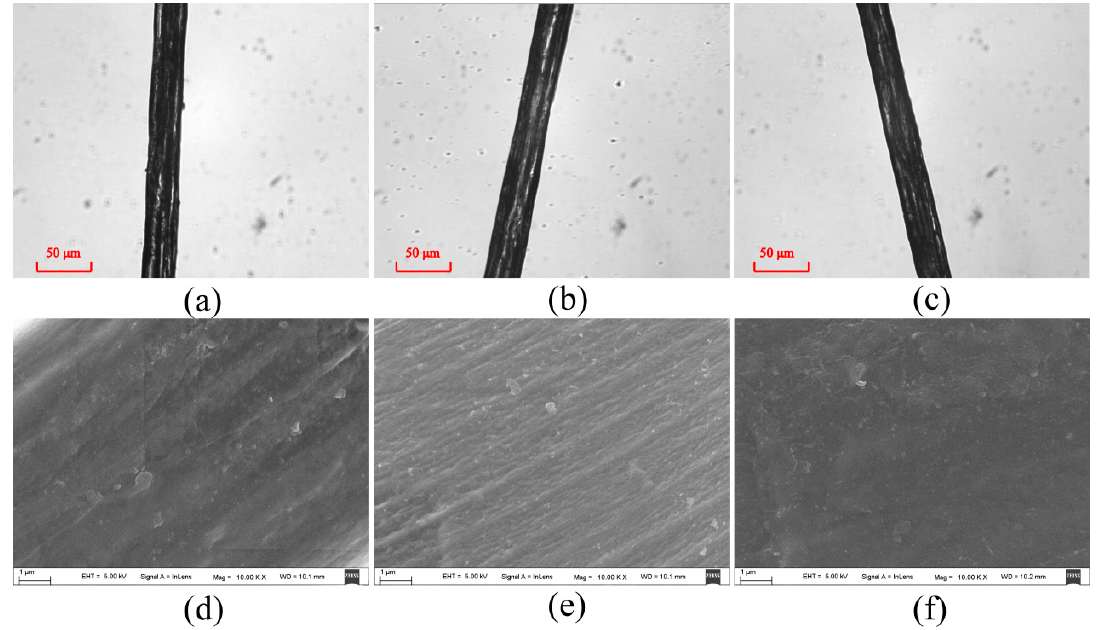
Figure 6. Optical microscopic images of silk samples in group A: ( a ) before washing; ( b ) after the sixth washing by fabric softener; ( c ) after the sixth washing by laundry powder. Scanning electron microscopic images (10,000×) of silk samples in group A: ( d ) before washing; ( e ) after the sixth washing by fabric softener; ( f ) after the sixth washing by laundry powder.